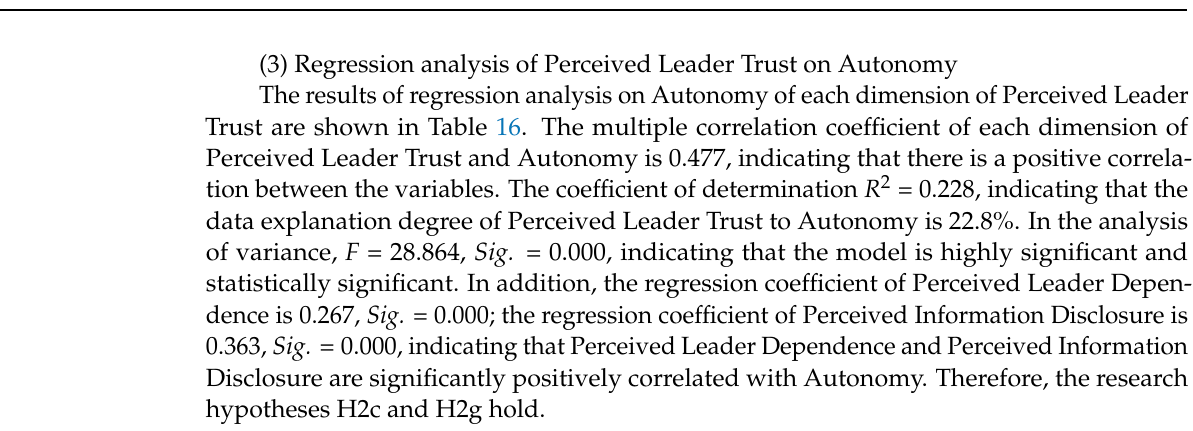
Table 16. Regression Analysis of Perceived Leadership Trust on